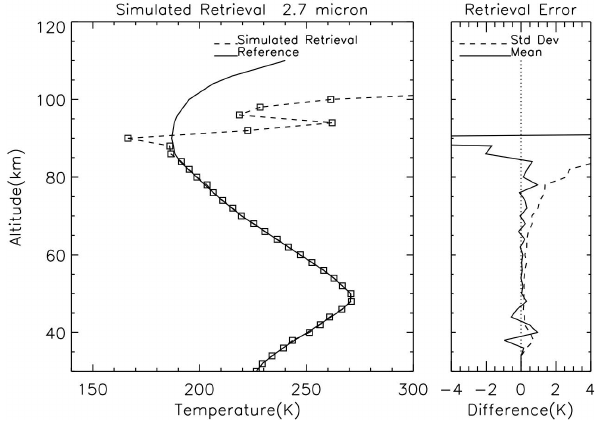
Fig. 13. Same as Fig. 11 but for the 2.7µm CO 2